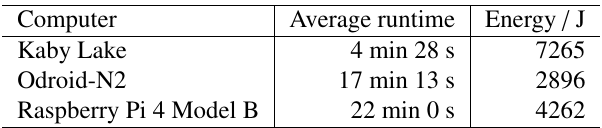
Table 5. Runtime and energy consumption of the CMSSW